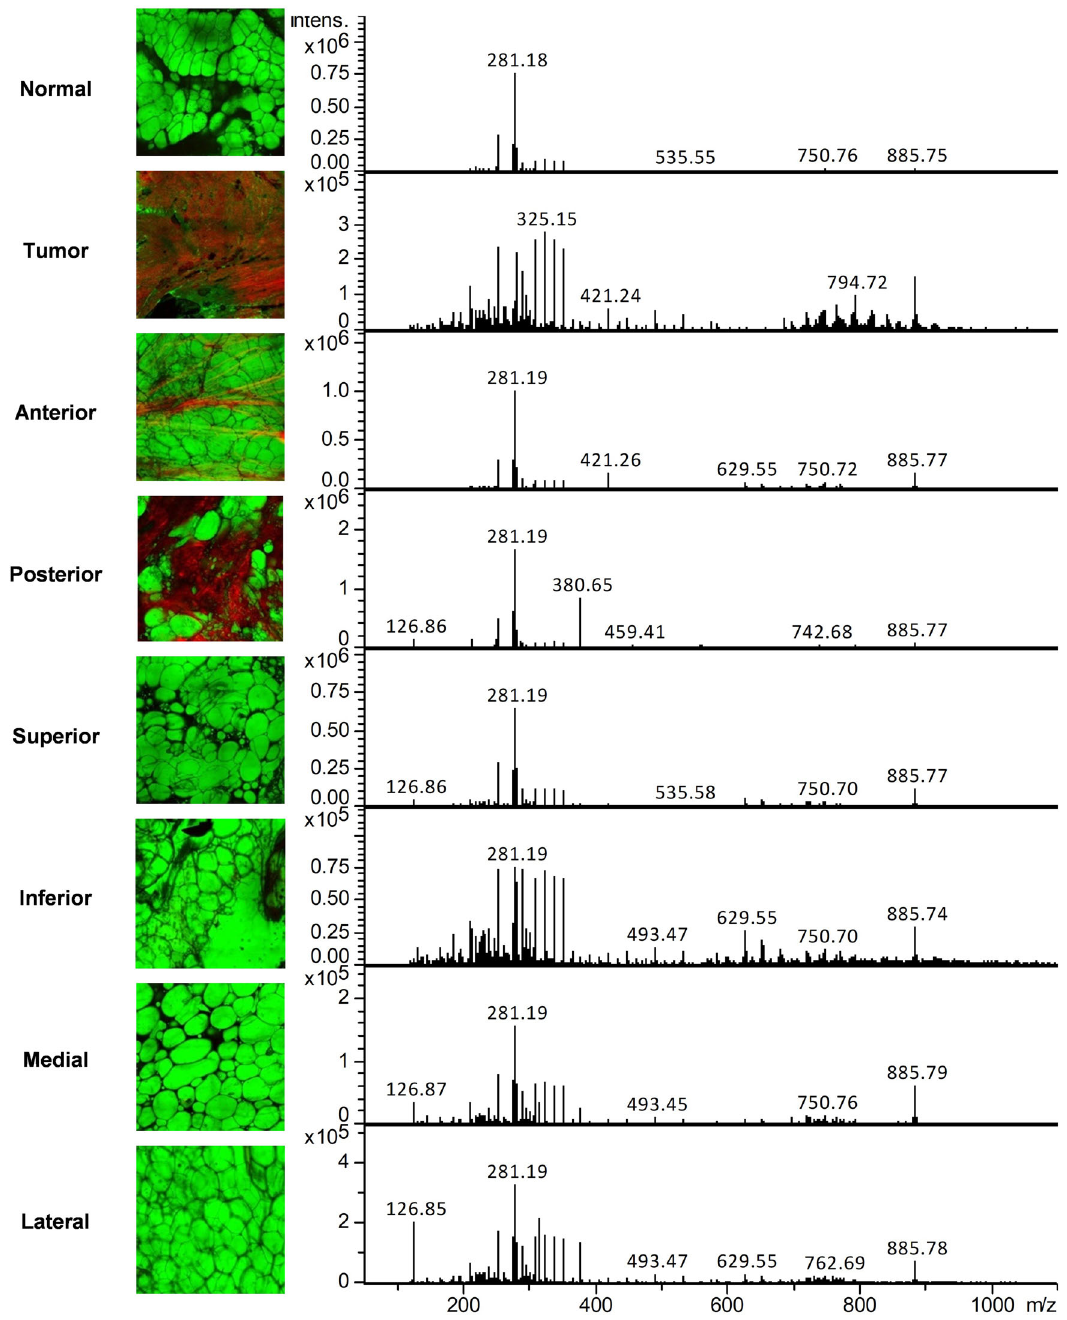
Fig. 3 SRS images and intraoperative mass spectra from the tumor, normal, and lumpectomy margins from Case 13. Pseudocolor green: SRS imaging of lipids in adipocytes; pseudocolor red: SHG imaging of collagen. Tumor tissue was featured by signi fi cantly reduced lipid contents and increased collagen